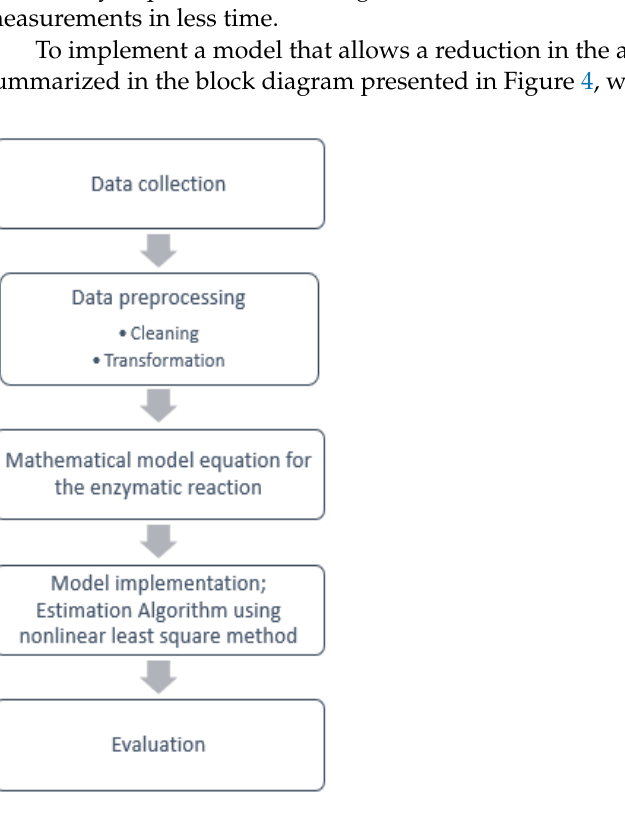
Figure 4. Block diagram for the proposed